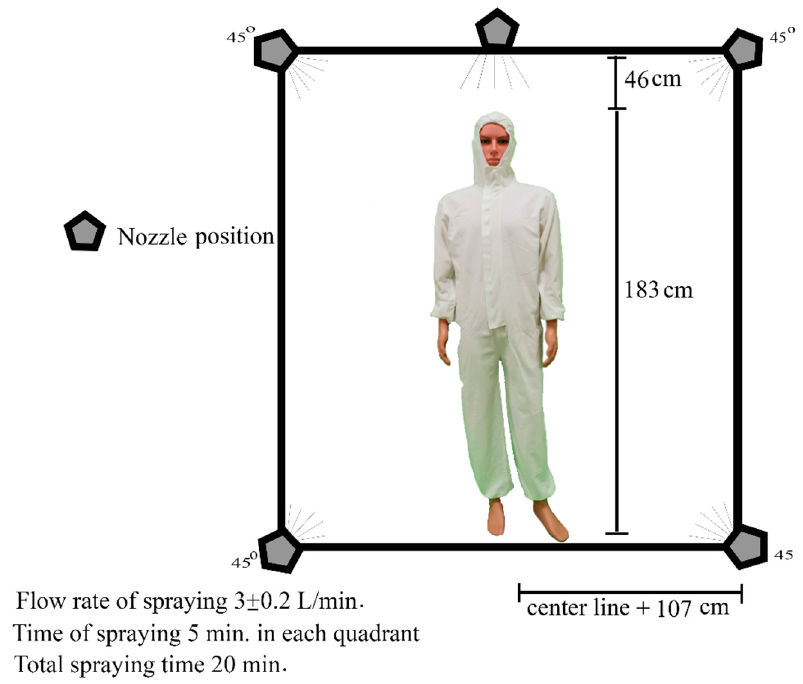
Figure 2. Closed chamber for experiment.